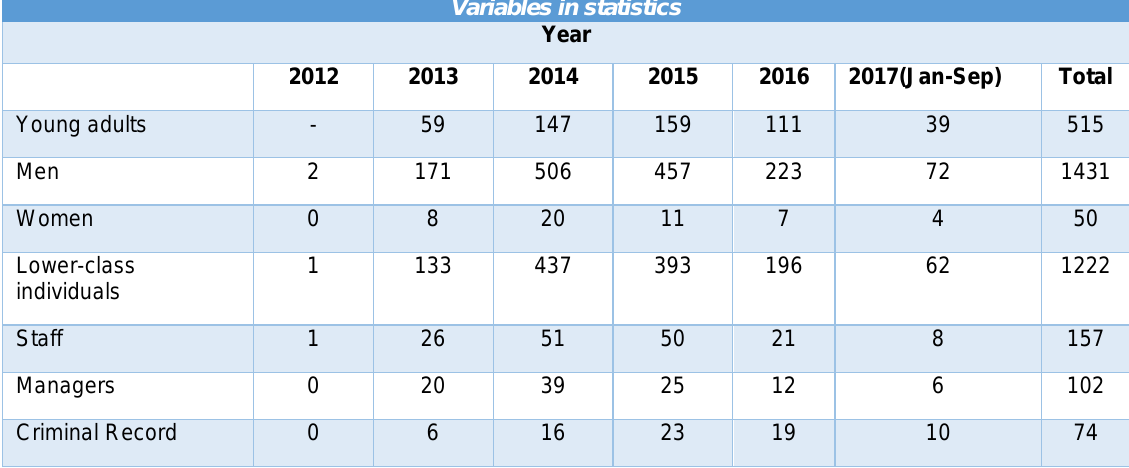
Table 1: Individuals involved in the illegal supply of controlled chemicals 2012-2017. Total = 1,481 Variables in